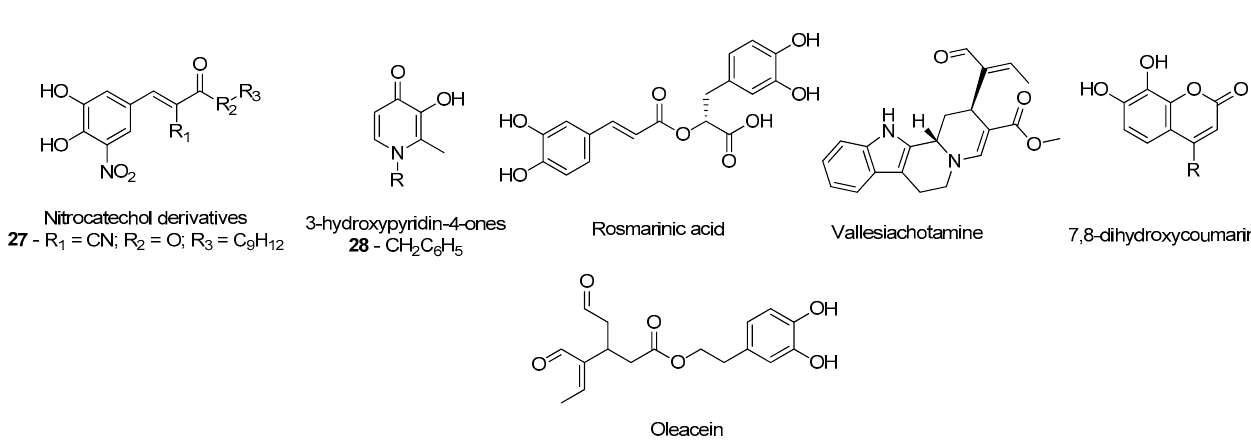
Figure 23. Structures of the studied COMT inhibitors.